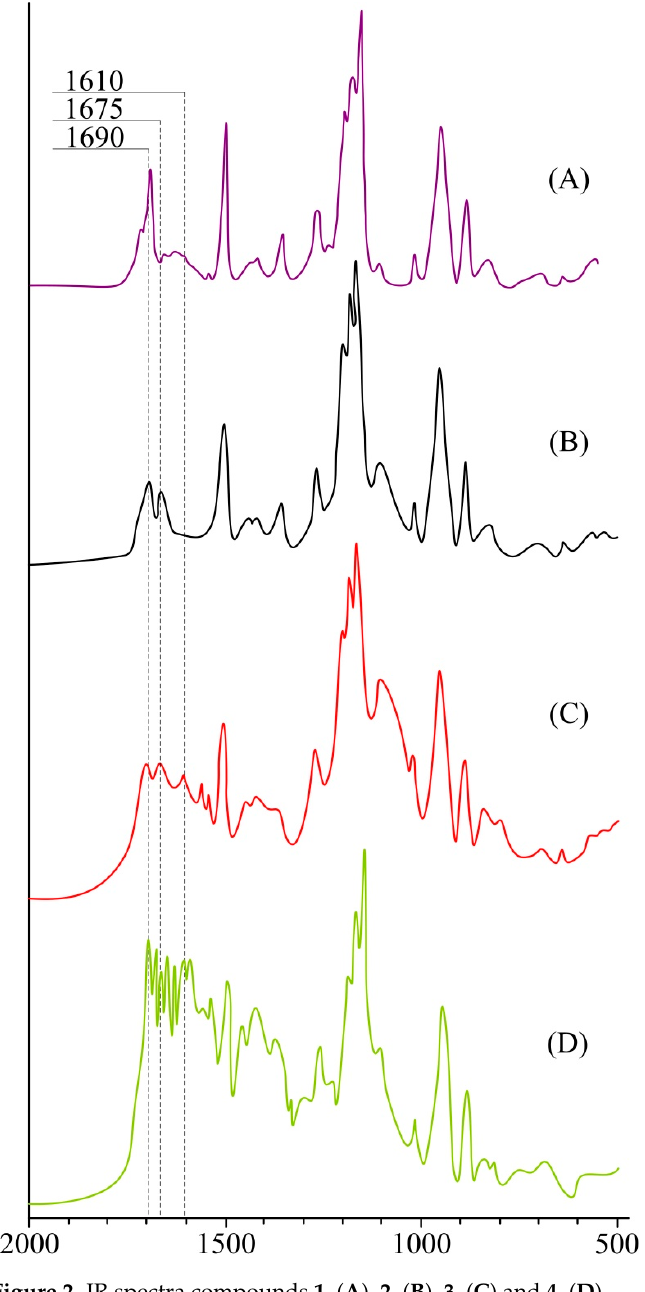
Figure 2. IR spectra compounds 1 –( A ), 2 –( B ), 3 –( C ) and 4 –( D ). It can be seen from the luminescence spectrum with excitation at 250 nm that there